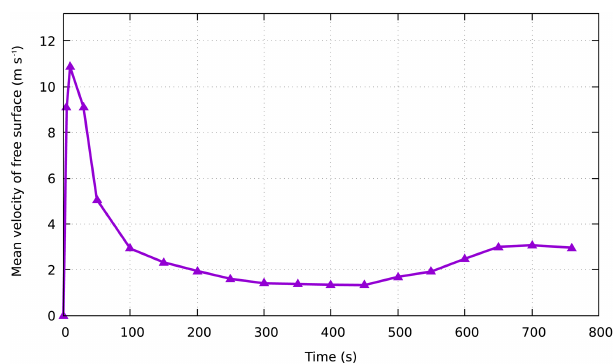
Figure 15. Average velocity time history for the free surface simu- lation of the A’xi dam failure.